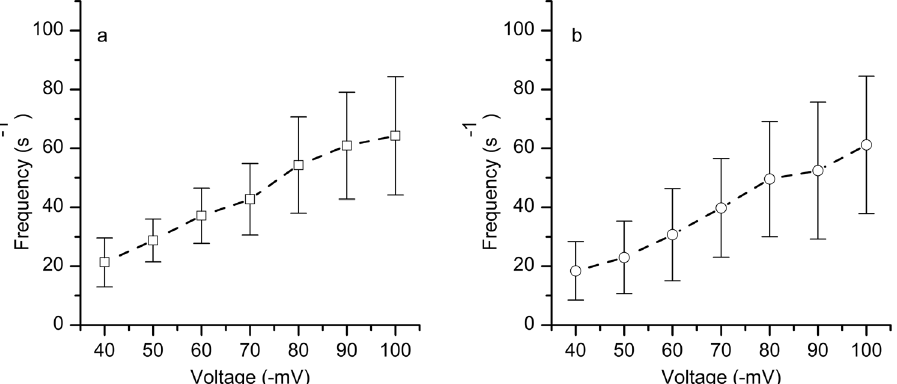
Figure 4. The effect of voltage on event frequency. The frequency of E1 events ( a ) and E2 events ( b ) estimated for a single lysenin channel follows the applied voltage in a quasi-linear manner. The experimental points represents mean ± s.d, n =